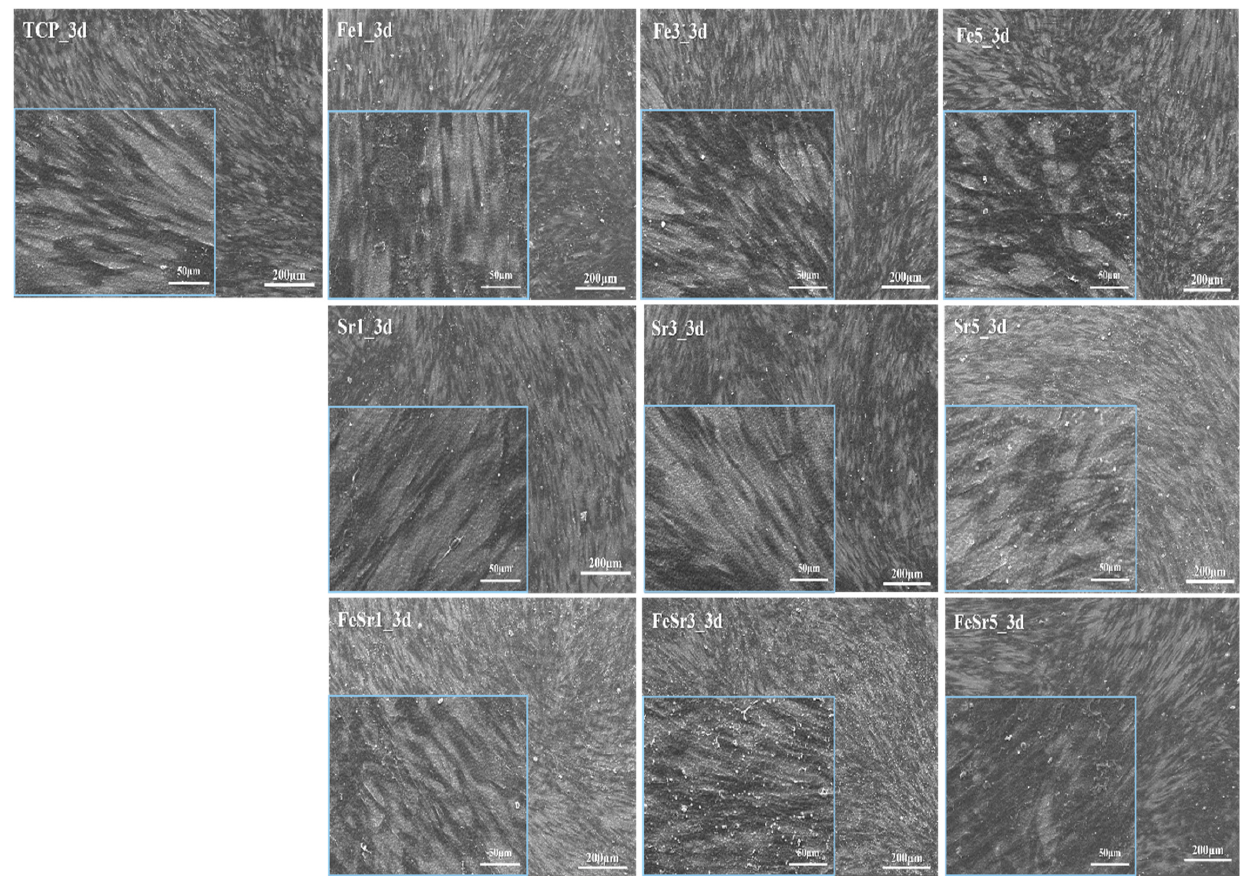
Figure 15. The morphology of hDPSC on the Fe- and Sr-substituted discs. (3 days).